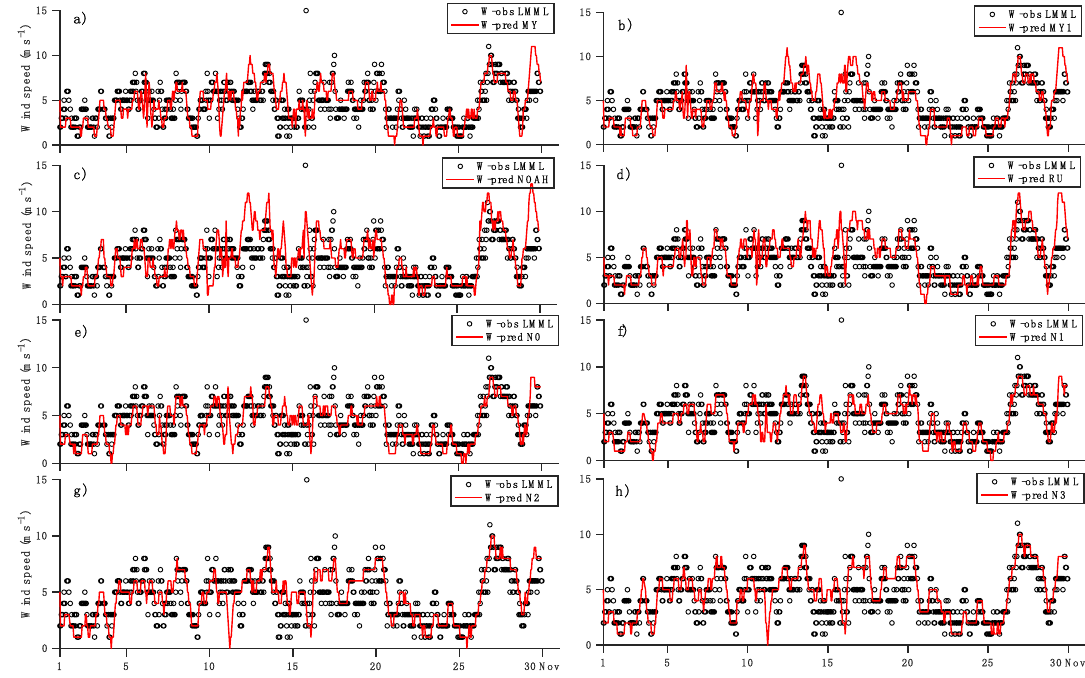
Figure 9. Time series of wind speed observed at LMML meteorological station versus wind speed predicted by MY ( a ), MY1 ( b ), NOAH ( c ), RU ( d ), N0 ( e ), N1 ( f ), N2 ( g ), and N3 ( h ) simulations.